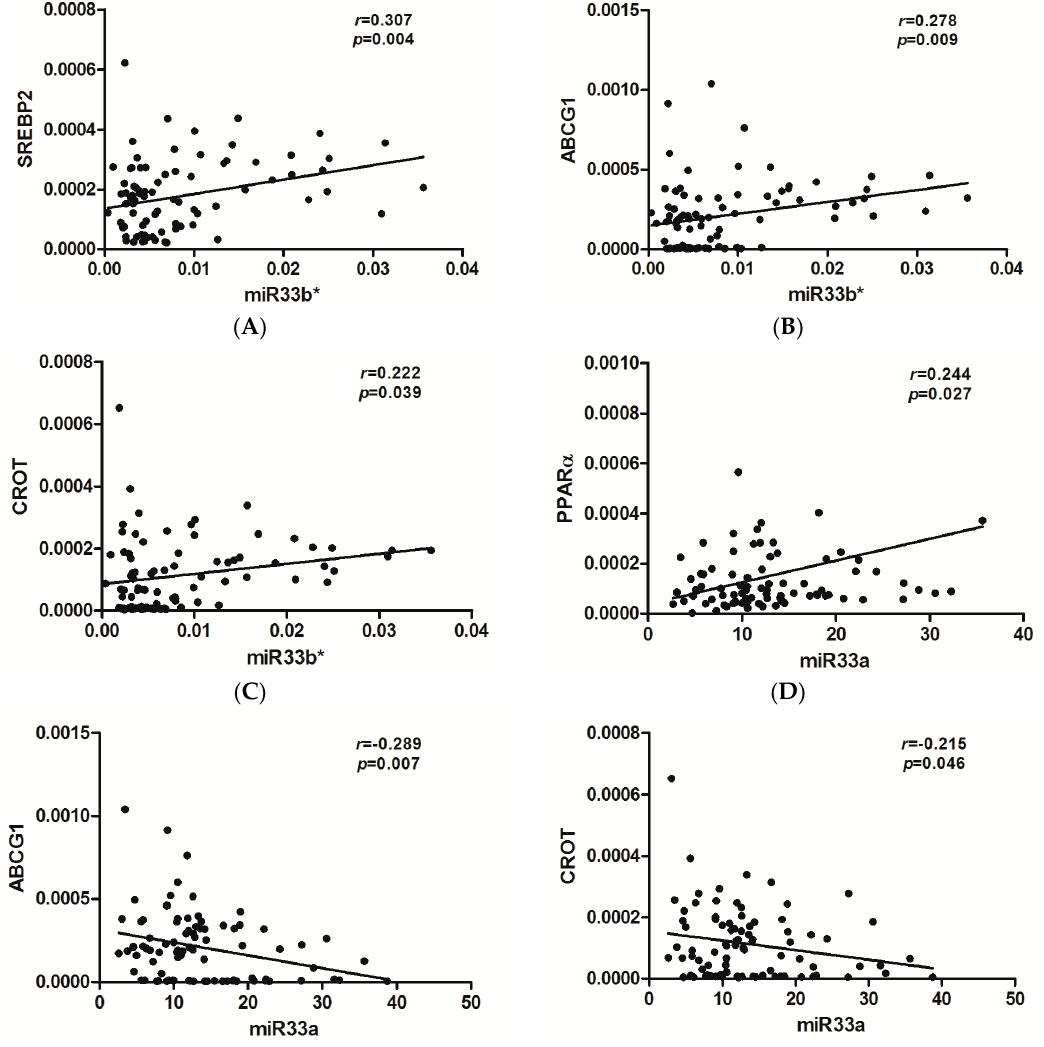
Figure 4. Correlation of the liver expression of miR33b* ( A – C ) and miR33a ( D – F ) with the liver expression of genes involved in lipid metabolism: lipogenesis, fatty acid oxidation and hepatic secretion of lipoproteins. SREBP2 , sterol-regulatory-element-binding protein; ABCG1 , ATP binding cassette transporters G1; CROT , carnitine O -octanoyltransferase; PPAR α , peroxisome-proliferator-activated receptor α . The strength of association between variables was calculated using Spearman’s r correlation test. p < 0.05 is considered statistically significant.